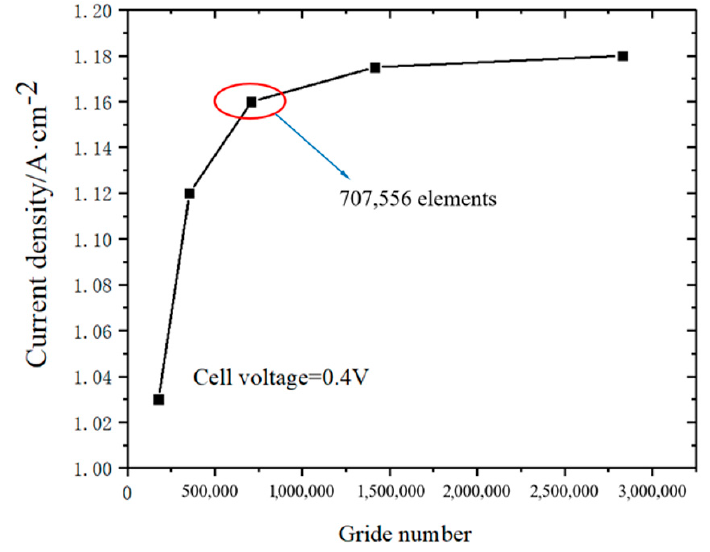
Figure 3. Grid independence testing result.